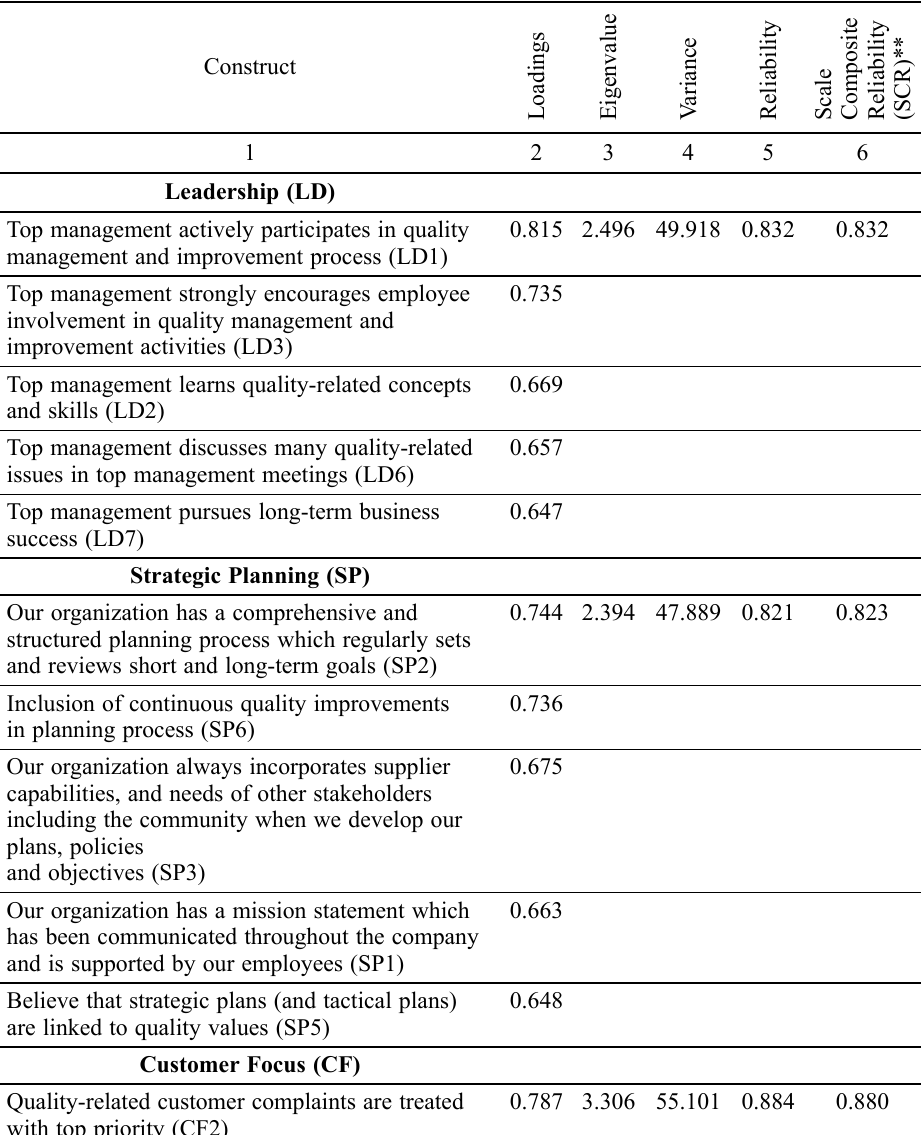
Table 2. Factor analysis of TQM